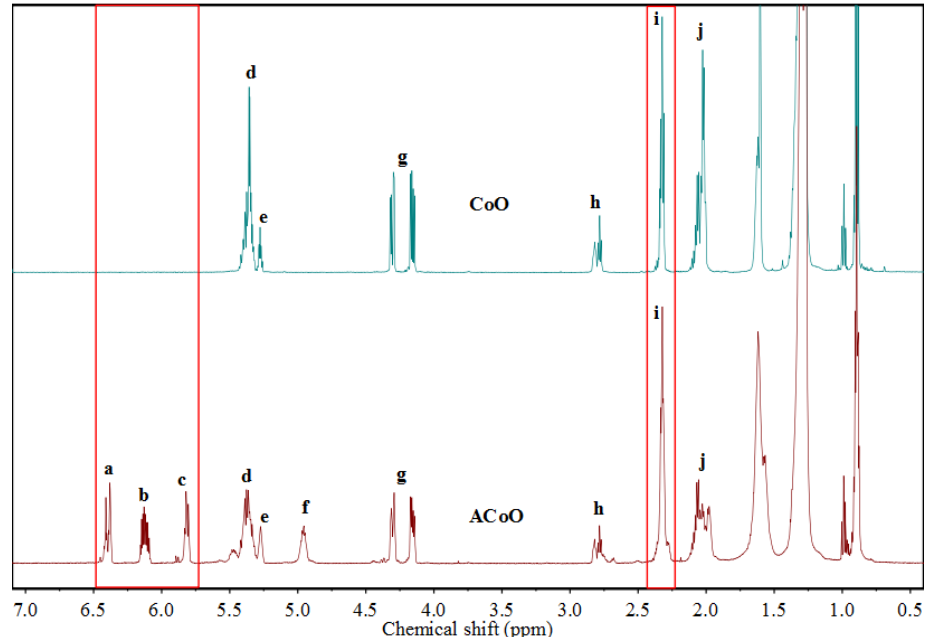
Figure 2. Proton nuclear magnetic resonance ( 1 H NMR) spectra of CoO and ACoO. Note: The lowercase letters corresponded to the protons in Scheme 2. Table 1. Grafting number and grafting rate of different vegetable oil-based acrylate prepolymers.